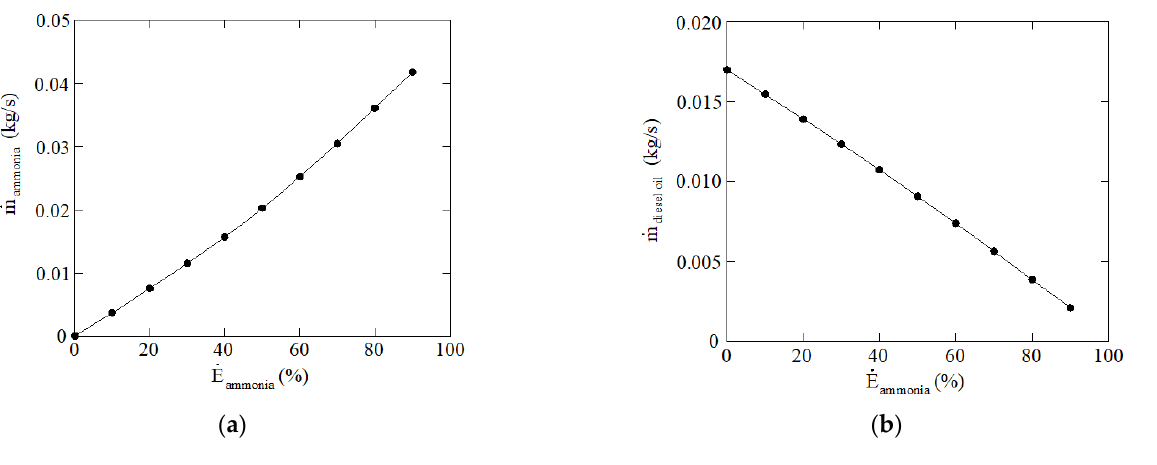
Figure 8. ( a ) Mass flow of ammonia fuel against the percentage of power contribution from ammonia. ( b ) Mass flow of diesel oil fuel against the percentage of power contribution from ammonia.